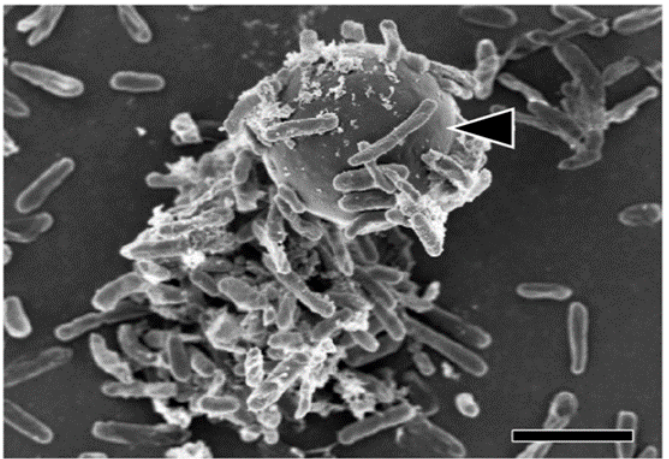
Figure 1. Scanning electron micrograph showing a Cryptosporidium oocyst (see [26] for methods). Scale bar = 3 μ m.